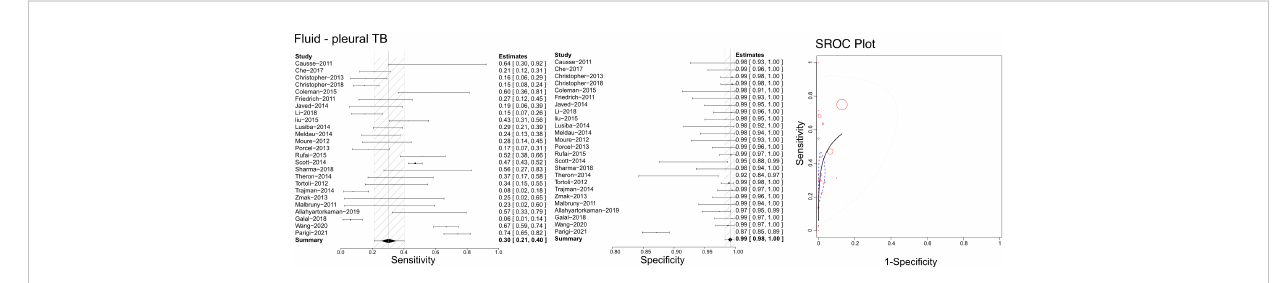
FIGURE 6 The sensitivity, speci fi city and SROC curve of different samples for diagnosing pleural TB on fl uid sample based Xpert